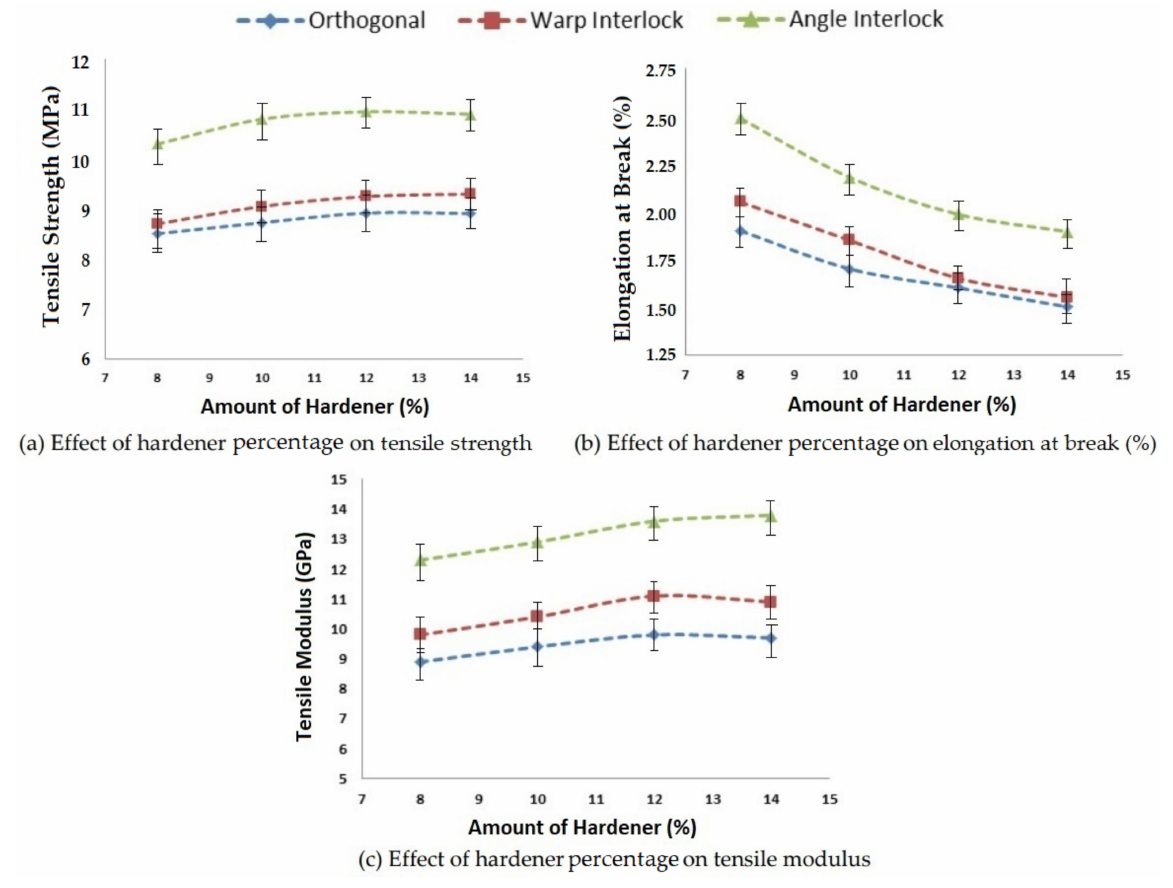
Figure 5. Effect of the amount of hardener percentage on the tensile properties of 3D woven composites.